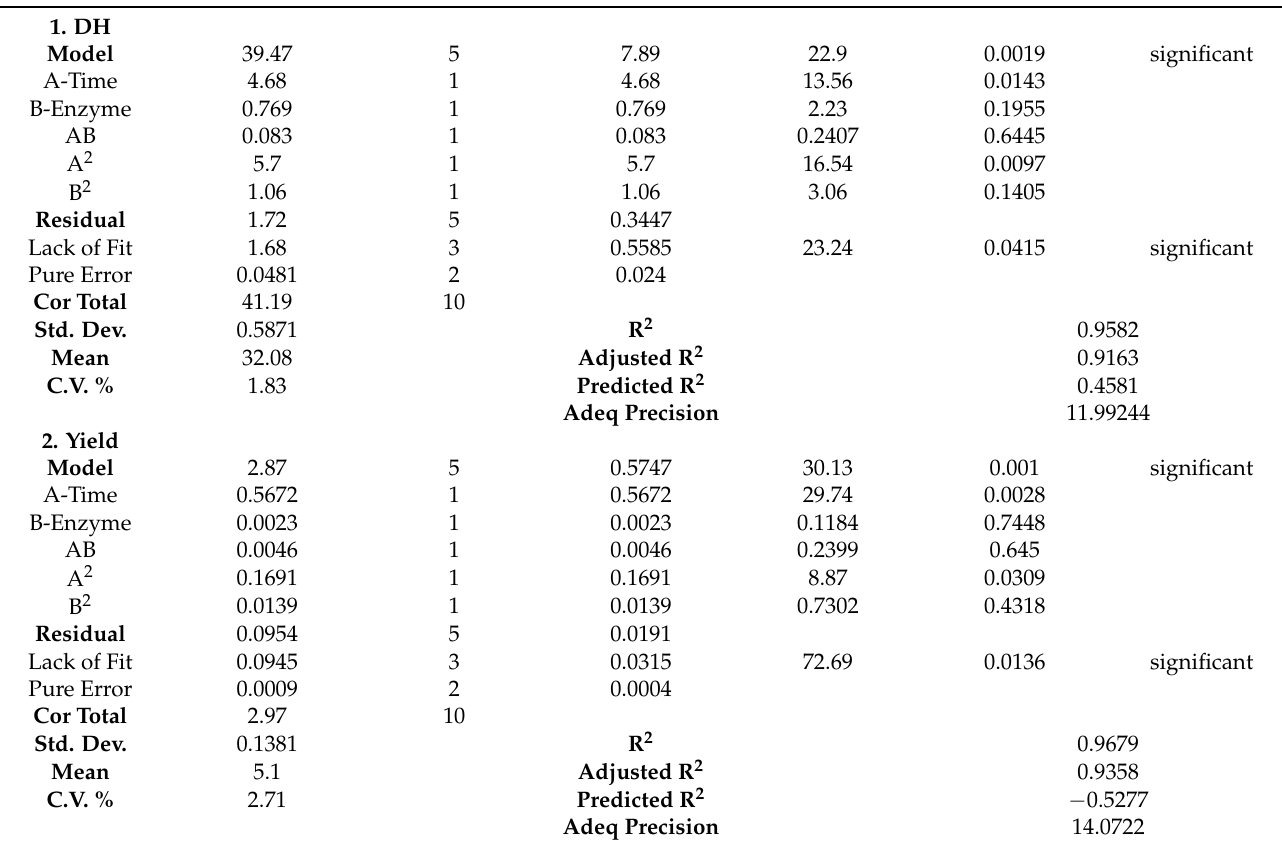
Table A1. The observed effects due to the hydrolysis variables including digestion time (A) and enzyme usage (B) on the response values for degree of hydrolysis (DH) and %yield.